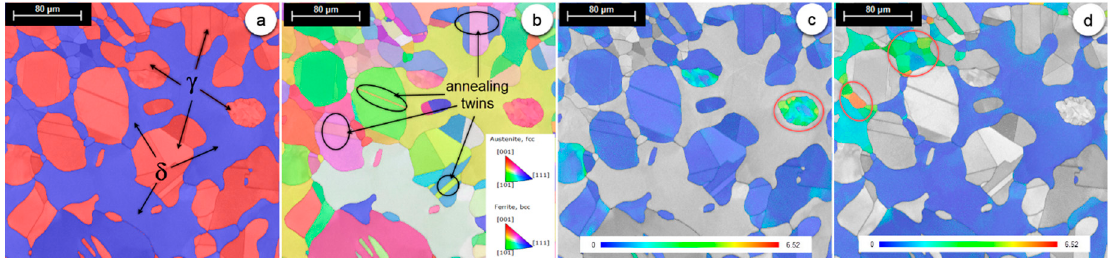
Figure 3. Distribution map of the γ - and δ -phases ( a ), inverse pole figure (IPF) ( b ), grain reference orientation deviation (GROD) map of γ -phase ( c ) and δ -phase ( d ) for the as-received ( AR ) state.